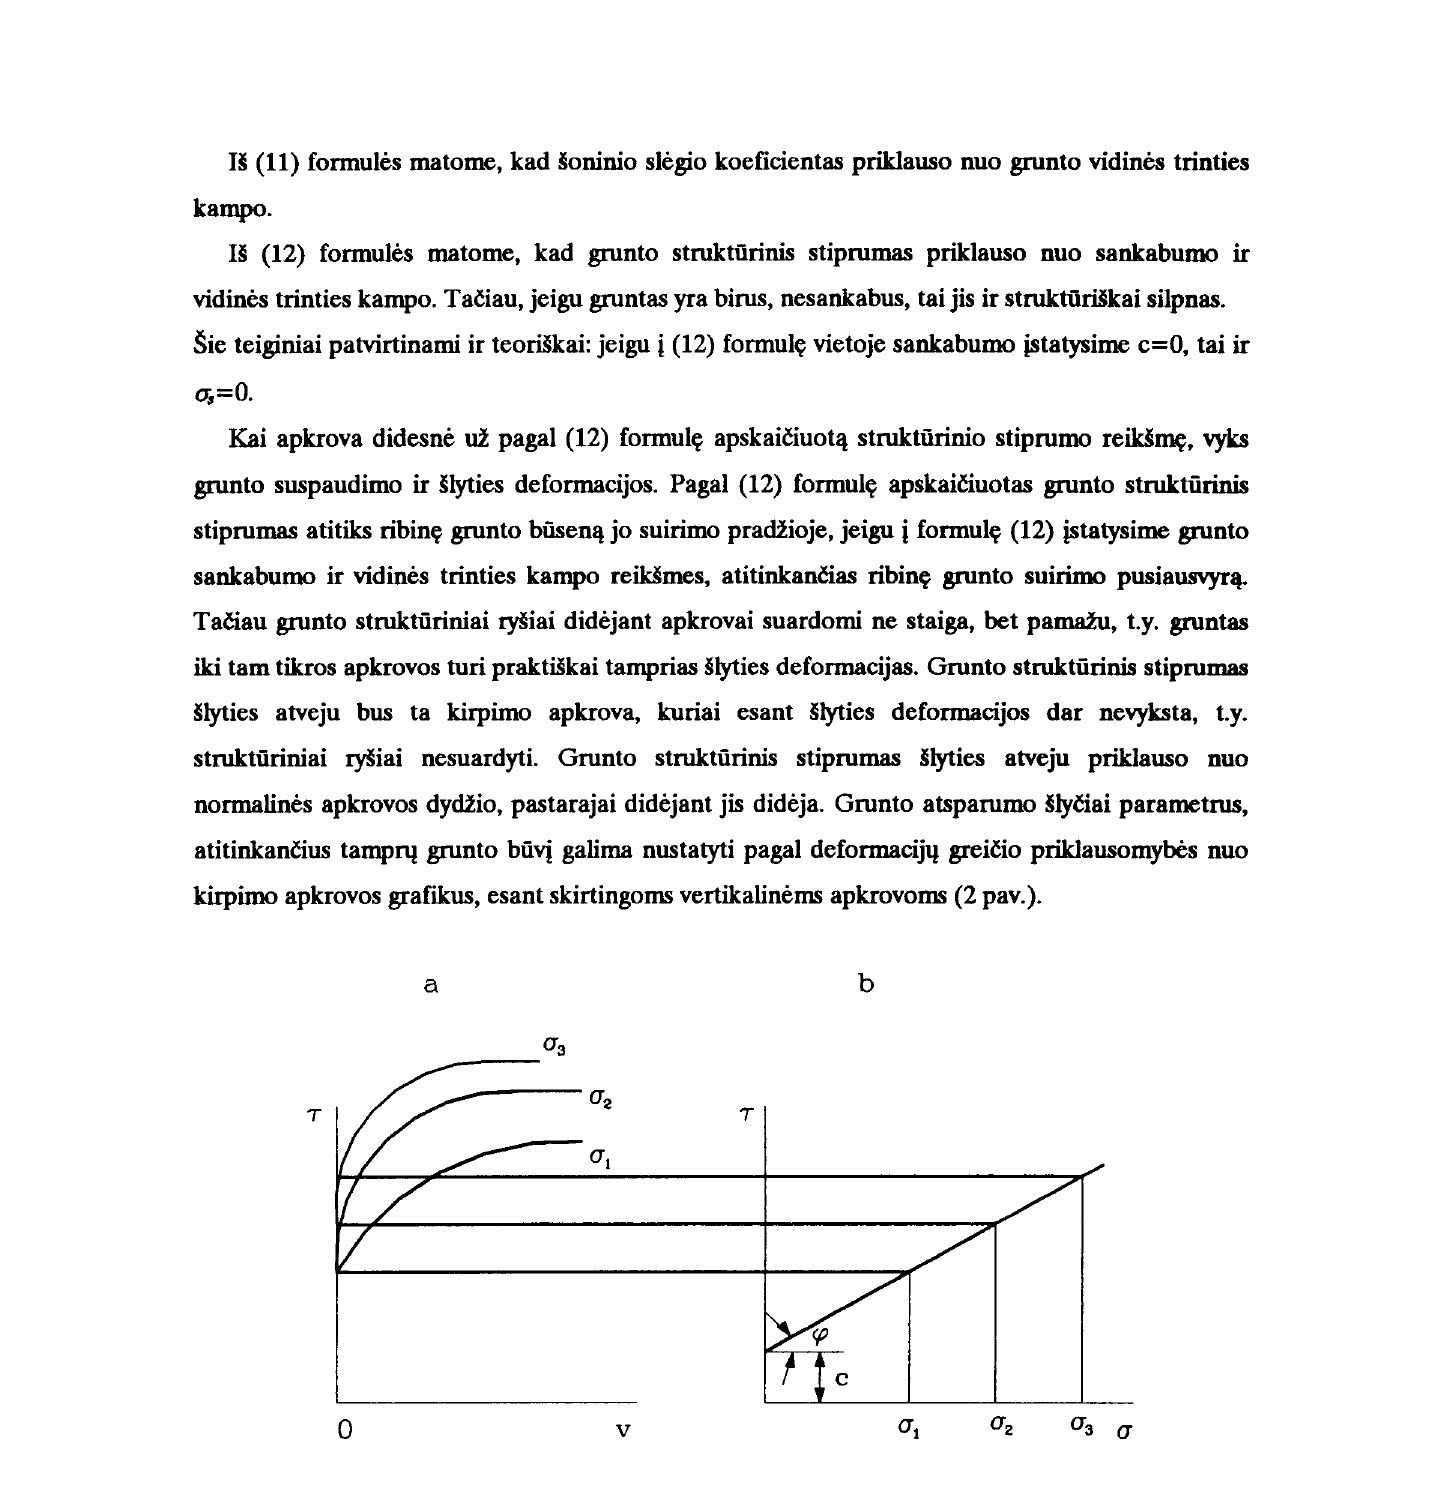
U (11) formules matome, kad §oninio slegio koeficieDtas priklauso Duo gruDto vidiDes triDties kampo. U (12) formules matome, kad gruDto struktfirinis stiprumas priklauso DUO sankabumo ir vidiDes triDties kampo. TaCiau, jeigu gruDtas yra birus, Desankabus, tai jis ir struktfimkai silpDas. Sie teiginiai patvirtiDami ir teorukai: jeigu i (12) formul~ vietoje sankabumo istatysime c=O, tai ir